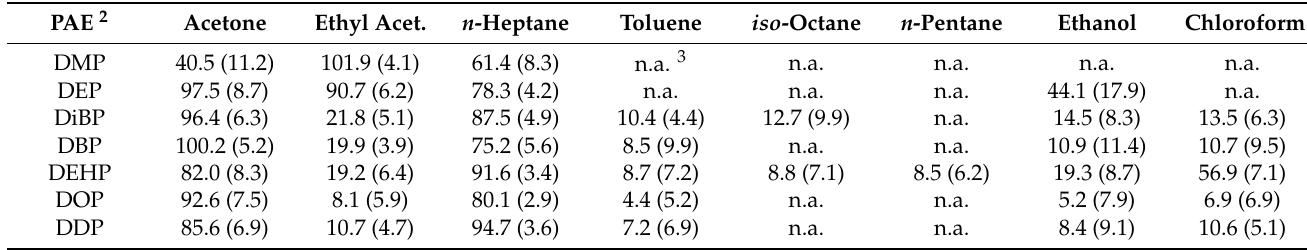
Table 1. Recoveries (%) of each PAE in relation to different solvents used for the extraction. In brackets are reported the coefficients of variation (cv%) 1 .